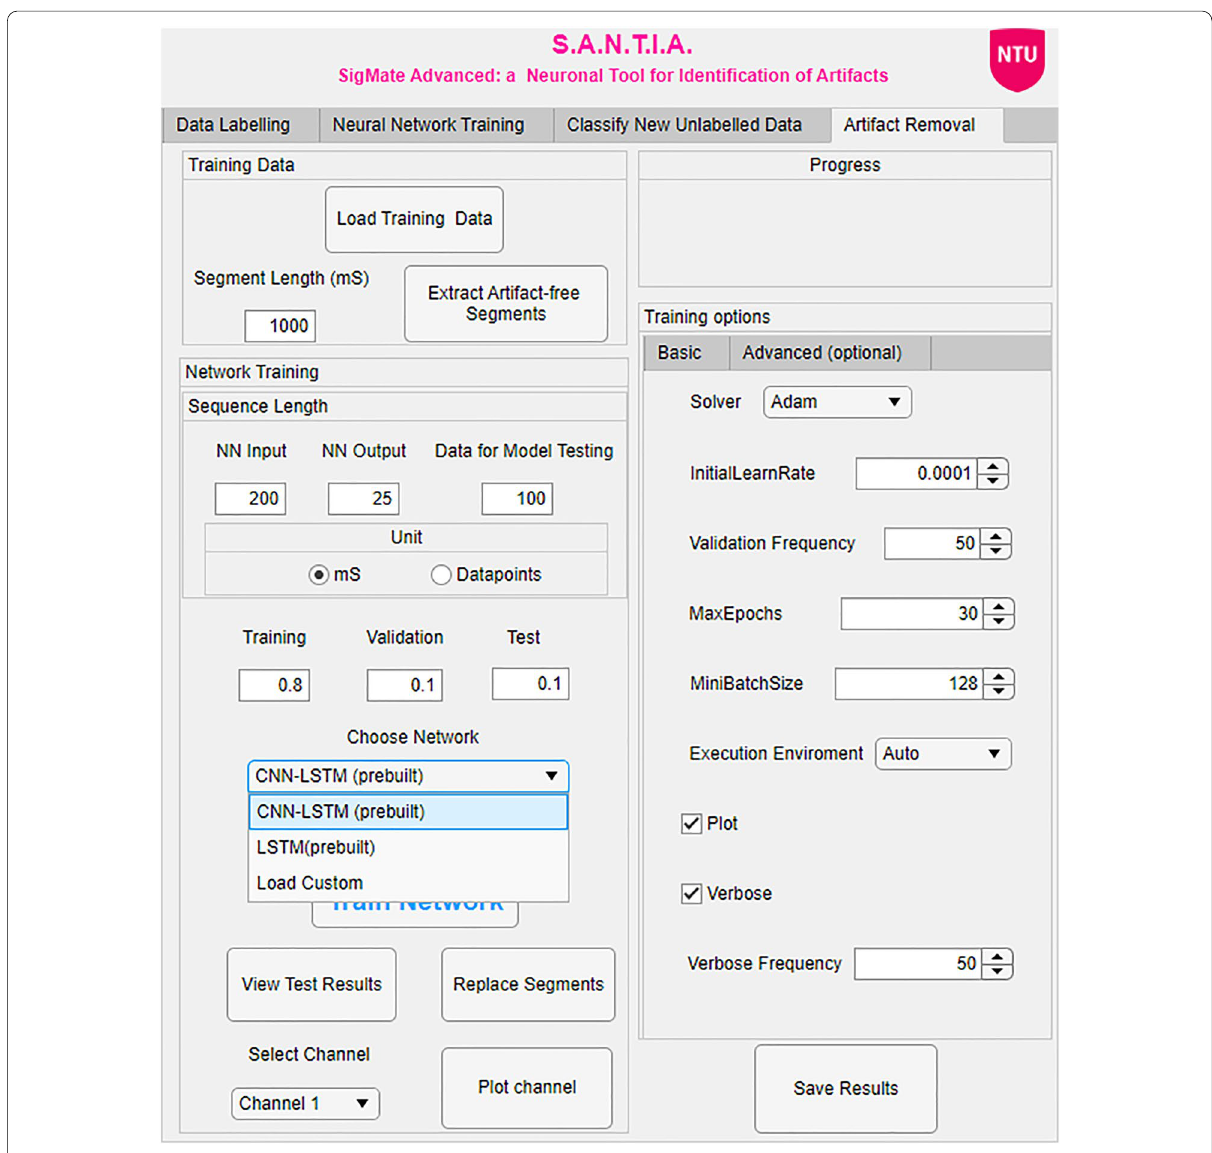
Fig. 3 Architecture selection option of the artefact removal module in the SANTIA